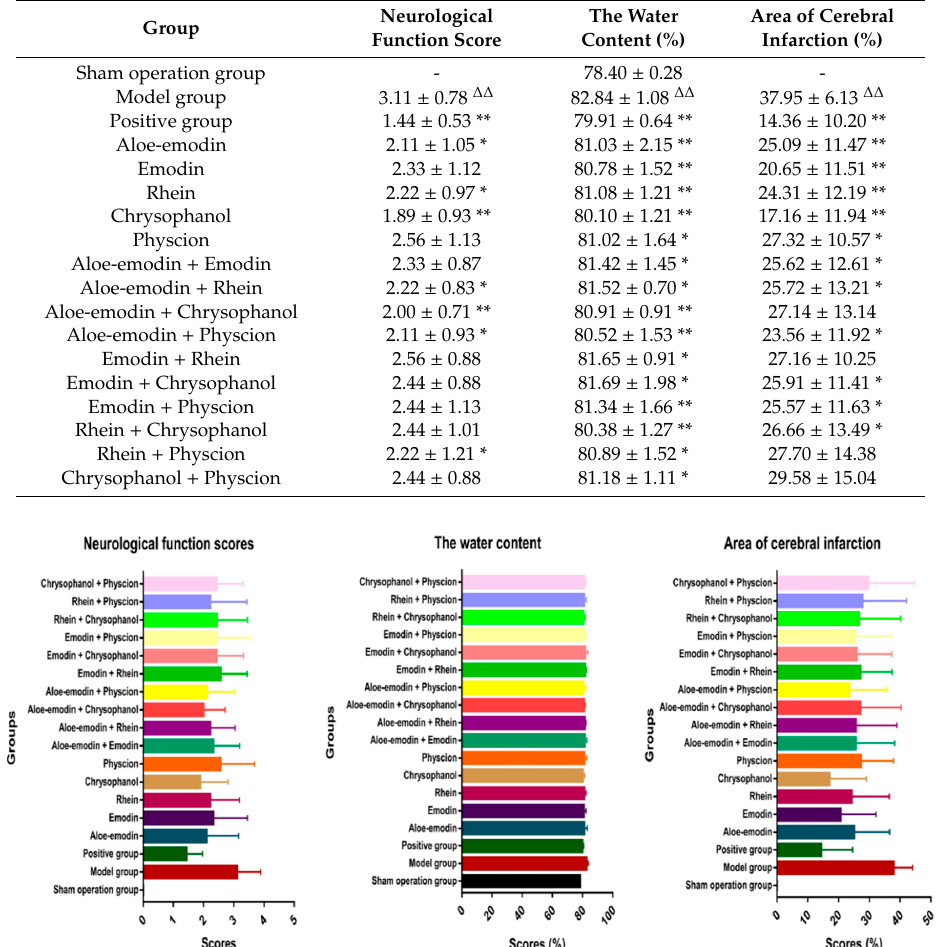
Table 1. Pharmacodynamic index: the neurological function scores, the water content, and area of cerebral infarction. The results were expressed as means ± standard deviation. One-way ANOVA and bilateral inspection were used to analyze the data differences between the groups by some standards that Δ , * p < 0.05; ΔΔ , ** p < 0.01. Δ showed the comparison between the sham operation group, * showed the comparison between the model group.